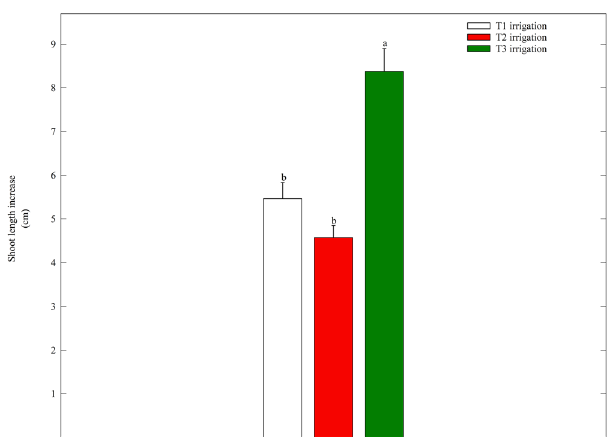
Figure 4: E ff ect of three irrigation regimes on shoot length increase for olive trees ( Olea europaea L. cv. “ Arbequina ” ) growing in Orchard 3 ( located near Artesia Wells, TX ) . Letters above each bar represent di ff erences between T1 ( single irrigation emitter ) , T2 ( two irrigation emitters ) , and T3 ( control, three irrigation emitters ) irrigation treatments ( Tukey – Kramer test, P ≤ 0.05 ) . Error bars represent SE for each irrigation